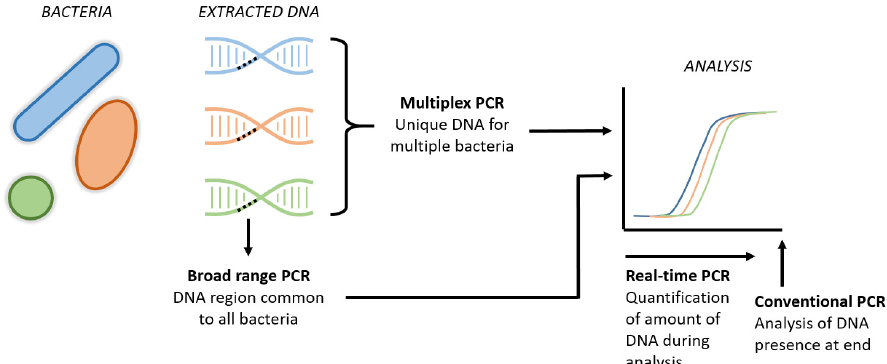
Figure 2. Schematic visualization of new PCR techniques. The broad range PCRs refers to the analysis of a common region present in all bacteria, aiming to detect the presence of bacterial DNA in general. Multiplex PCR includes the simultaneous DNA analysis of several specific bacteria in one tube. Real-time PCR is the new technique that enables us to quantify the amount of DNA throughout the entire analysis, instead of the presence of DNA at the end of the analysis in conventional PCR.